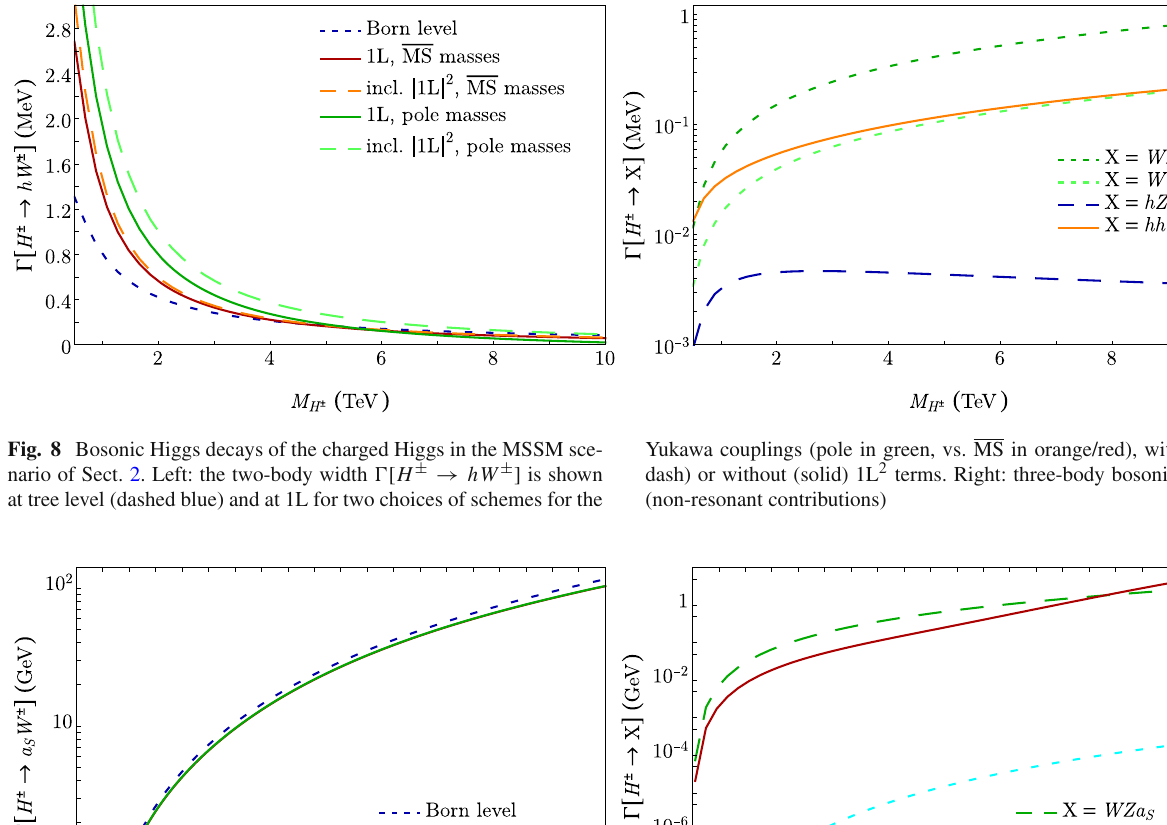
the Yukawa couplings (pole in green, vs. MS in red). Right : three-body bosonic widths involving a S (non-resonant